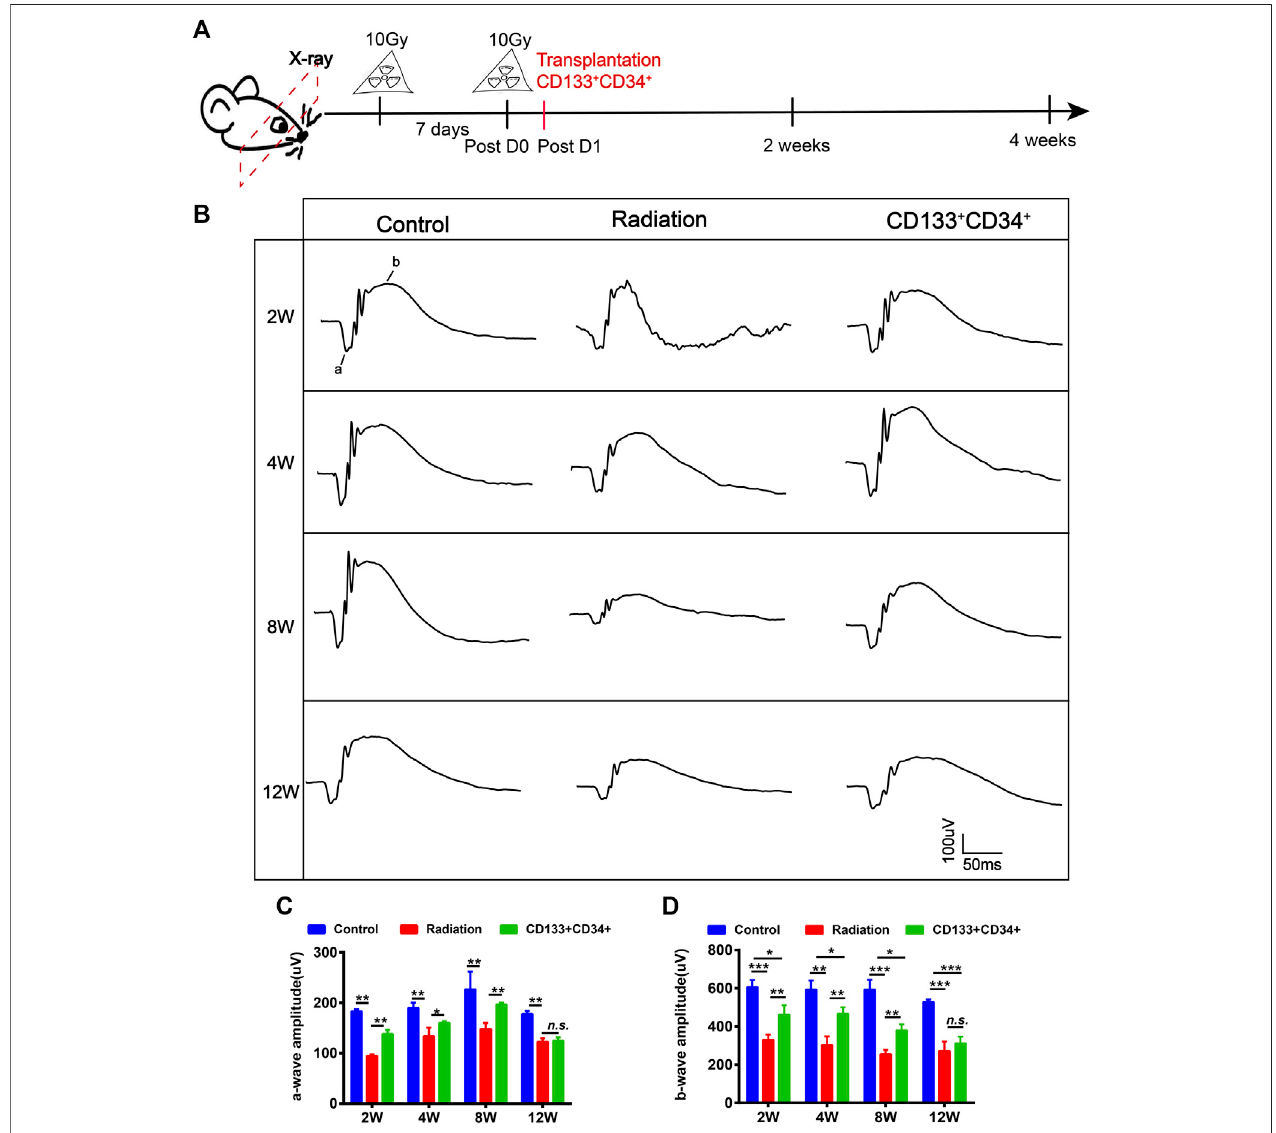
FIGURE3| TransplantedCD133 + CD34 + cellsimprovedretinaldysfunctionofirradiatedLErats. (A) :Theschematicdiagramofdesignforirradiatedratmodelsand cell transplantation experiment. (B) : The a- and b-wave amplitude of ERG from control, irradiated, and transplanted group. (C,D) : The statistics of a- and b-waves amplitude on control, irradiated, and cell transplanted group from 2 to 12 weeks. N = 3. Data are depicted as means ± SEM. (* p < 0.05, ** p < 0.01, *** p < 0.001).